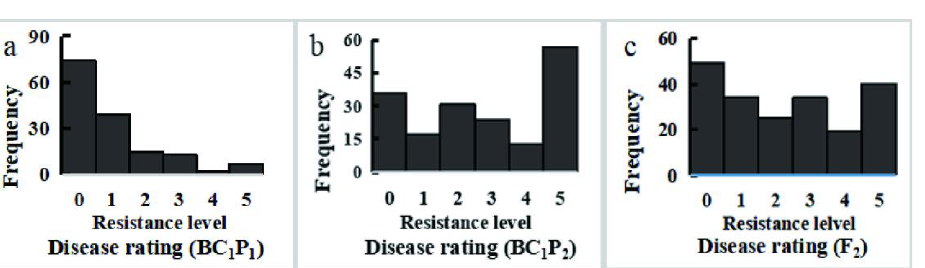
Table 3. The estimation of the maximum likelihood values and AIC values of the genetic model.